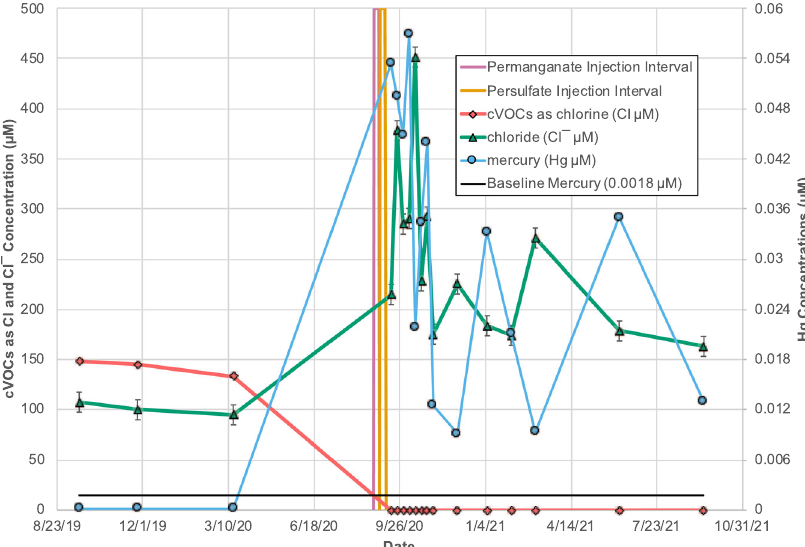
Fig. 4 Concentrations of cVOCs as chlorine, chloride, and mercury in WSM002C showing mercury concentrations after oxidant injections are more than fi ve times greater than baseline concentration. Reddish purple and orange lines indicate beginning and end of permanganate and persulfate solution injections, respectively. Vermillion line with vermillion diamonds mark concentrations of cVOCs as chlorine. Bluish green line with large bluish green triangles mark chloride concentrations, which increases as cVOCs are destroyed by oxidants. Sky blue line with sky blue circles mark concentrations of mercury, which signi fi cantly increase after oxidant injections. Black line indicates average baseline mercury concentration. Duplicate analyses of chloride were performed on 9/30/20 (range 20 µ M) and 6/9/21 (range 1 µ M) so conservative error bars of ±10 µ M were placed on all chloride data in the fi gure. A duplicate analysis of mercury (9/30/20) had a data range too small to see in this fi gure (0.0002 µ